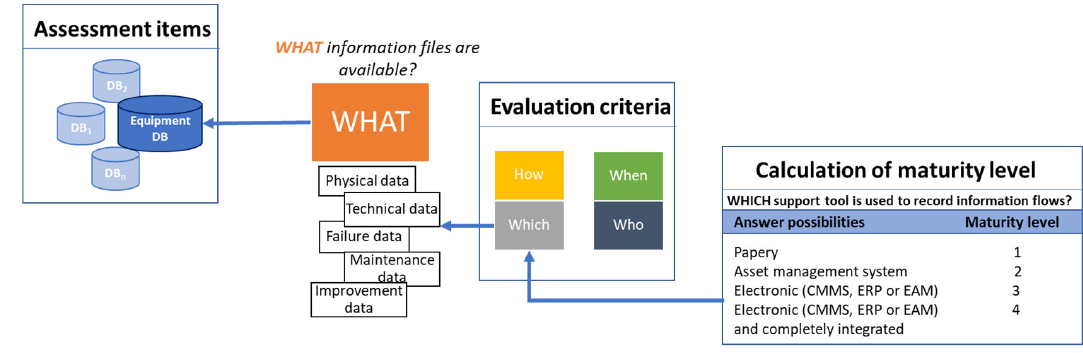
Figure 6. Example of a survey question.